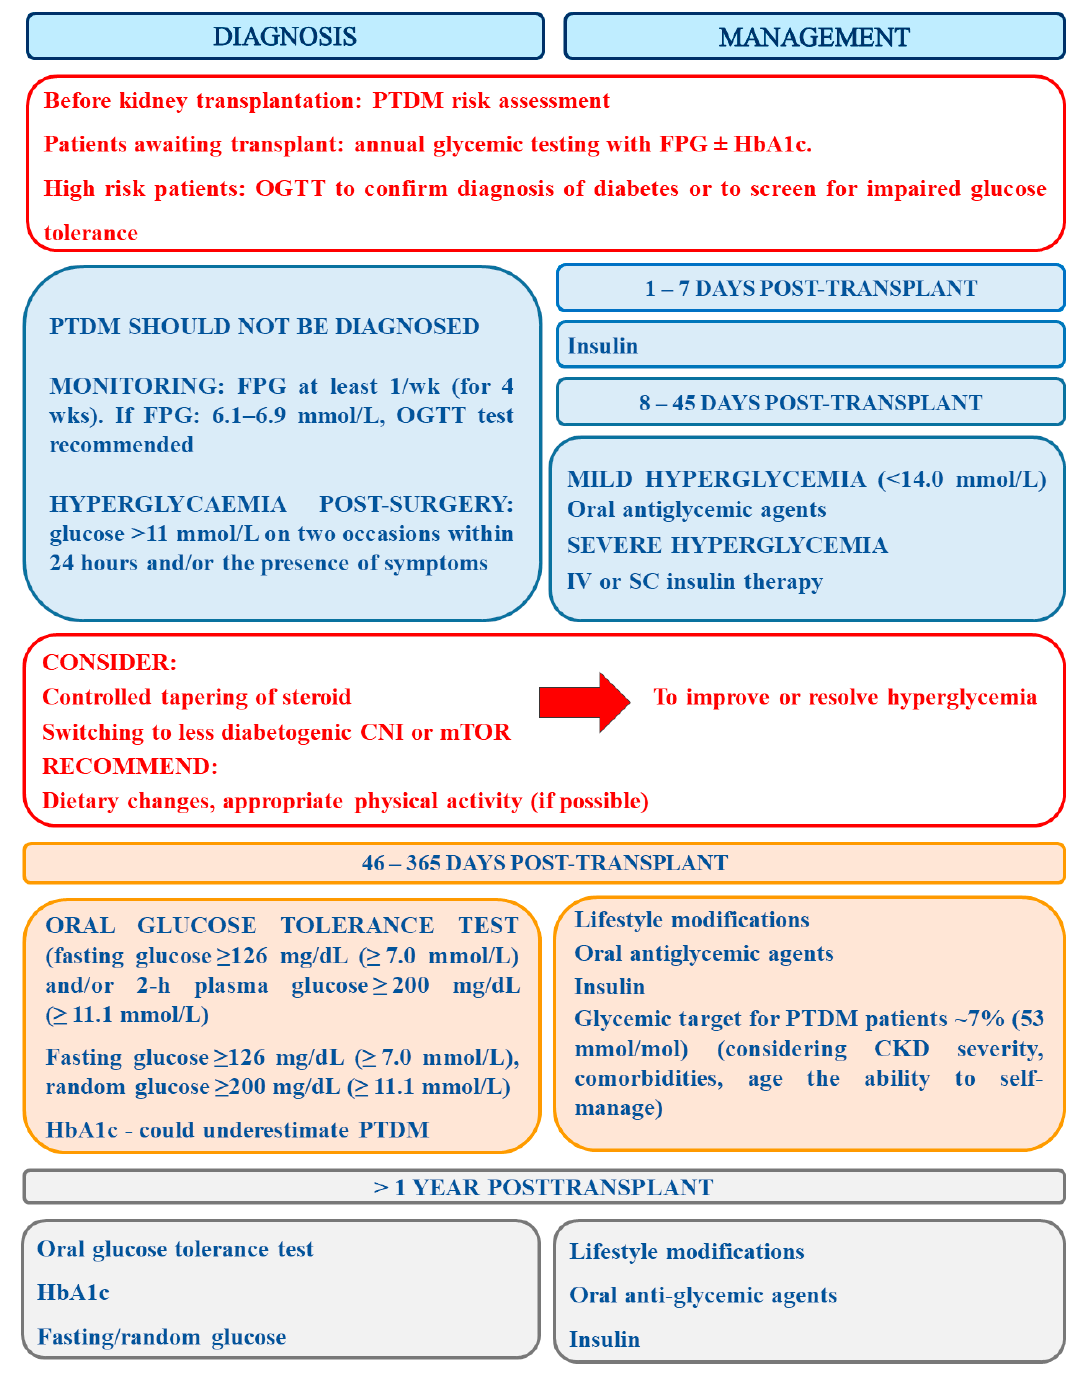
Figure 2. The summary of recommendations concerning PTDM diagnosis and management (prepared on the basis of [41,112,114].